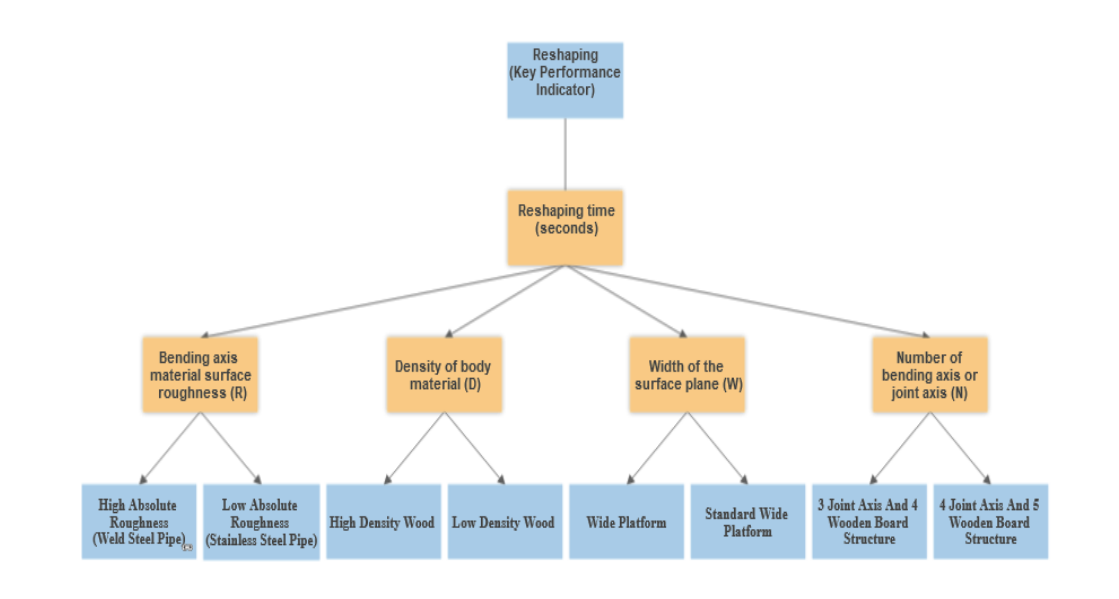
Fig. 2. Diagram showing parameters for DoE. Table 2. Design summary.